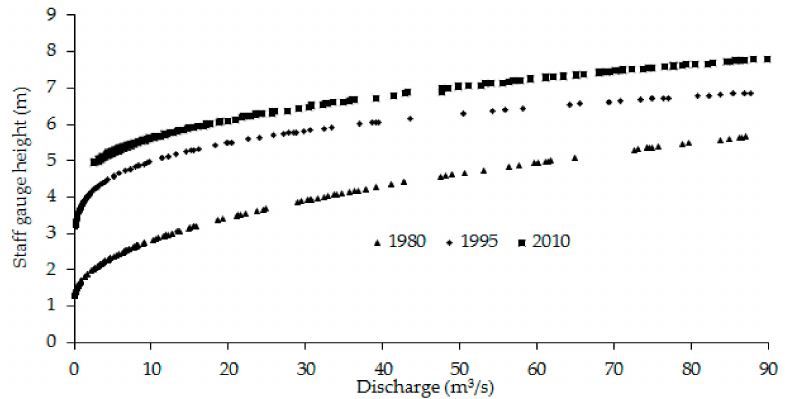
Figure 12. Ribb River staff level at the Lower gauging station with corresponding discharges (Data source: Ministry of Water, Irrigation and Energy,